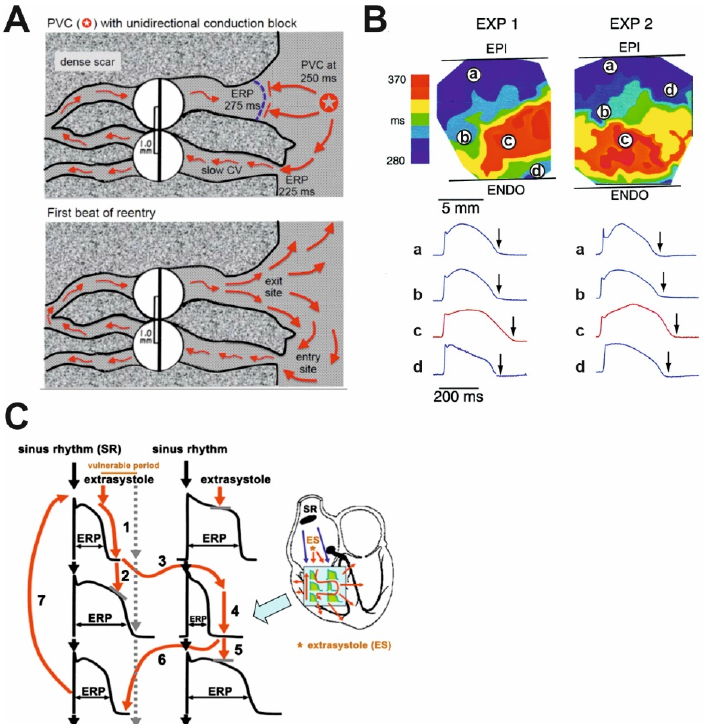
Figure 1. The simplified illustrations of mechanisms creating an arrhythmia substrate for reentry. ( A ) Illustrative example of a classic mechanism by which a premature ventricular complex (PVC) initiates reentry in the fibrotic border zone of the myocardium, due to slow conduction and dispersion of refractoriness. Top panel: a PVC occurring 250 ms following the previous beat arrives too early to conduct through the upper myocyte strand with a long ERP of 275 ms, but it propagates successfully (red arrows) through the lower strand with a shorter ERP of 225 ms (“entry site”). The impulse propagates slowly (slow CV), eventually reaching the upper strand from the opposite direction. Bottom panel: in case the conduction time is >275 ms, the interface of the upper strand with normal tissue (“exit site”) has recovered excitability, and the impulse can then propagate through the region of prior conduction block, thus initiating reentry. Dispersion of refractoriness is caused by electrical remodeling. The slow propagation is due to zig-zag conduction through the myocyte strands as well as gap junction remodeling. CV, conduction velocity; ERP, effective refractory period [15] . ( B ) Two representative exper- iments (EXP 1 and EXP 2) demonstrate spatial differences in duration of ventricular repolarization. Upper panel shows transmural heterogeneity of action potential durations using color codes during bradycardia and d-sotalol administration mimicking decreased repolarization reserve in the canine wedge long QT syndrome 2 model. Optical action potentials are shown from selected transmural sites (a, b, c, d) on lower panel. Arrows mark significant differences in the action potential duration within relatively short transmural distances. EPI, epicardium; ENDO, endocardium [14] . ( C ) The schematic il- lustration of functional reentry without a well-defined anatomical obstacle. The arrhythmia substrate is represented by artificially enhanced action potential duration differences. In normal settings, impulses from the sinus node (black arrows) use physiological pathways to propagate through atrial and ventricular tissue and the conduction system. An early trigger (red arrow) can only conduct via pathways where the tissue is not depolarized, and its refractoriness is over, whereas the conduction is blocked in other directions where the tissue is not fully repolarized and cells are refractory. Thus, the abnor- mal impulse can travel in a complicated pathway through reentry paths created by heterogeneous repolarization and conduction. The dispersion of repolarization creates a time window called the vulnerable period, where triggers could elicit the reentry arrhythmia. However, outside this window extra stimuli would only cause relatively harmless extrasys-